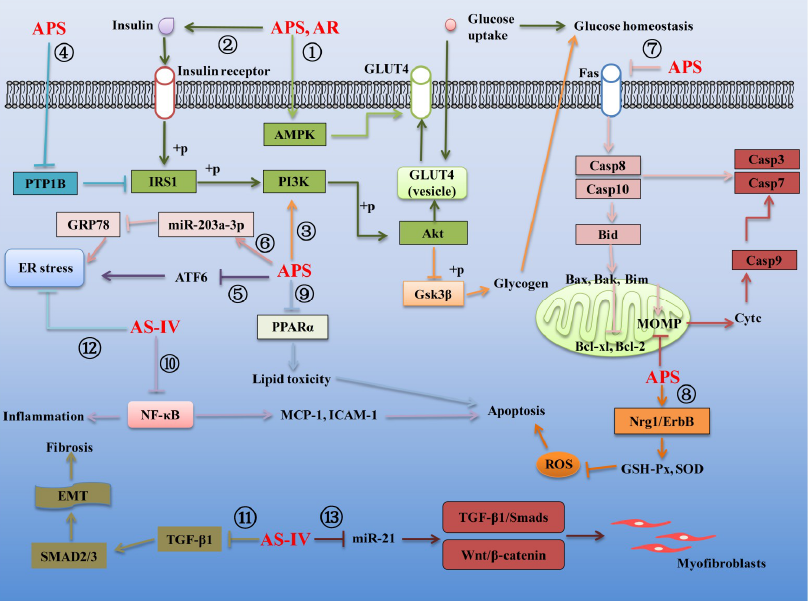
Figure 3. Several mechanisms linking AR and its main components to the treatment of type 2 diabetes mellitus. Arrows and bar-headed lines represent signaling activation and inhibition, respectively. The different signaling pathways regulated by AR and its components are numbered ① to ⑬ .